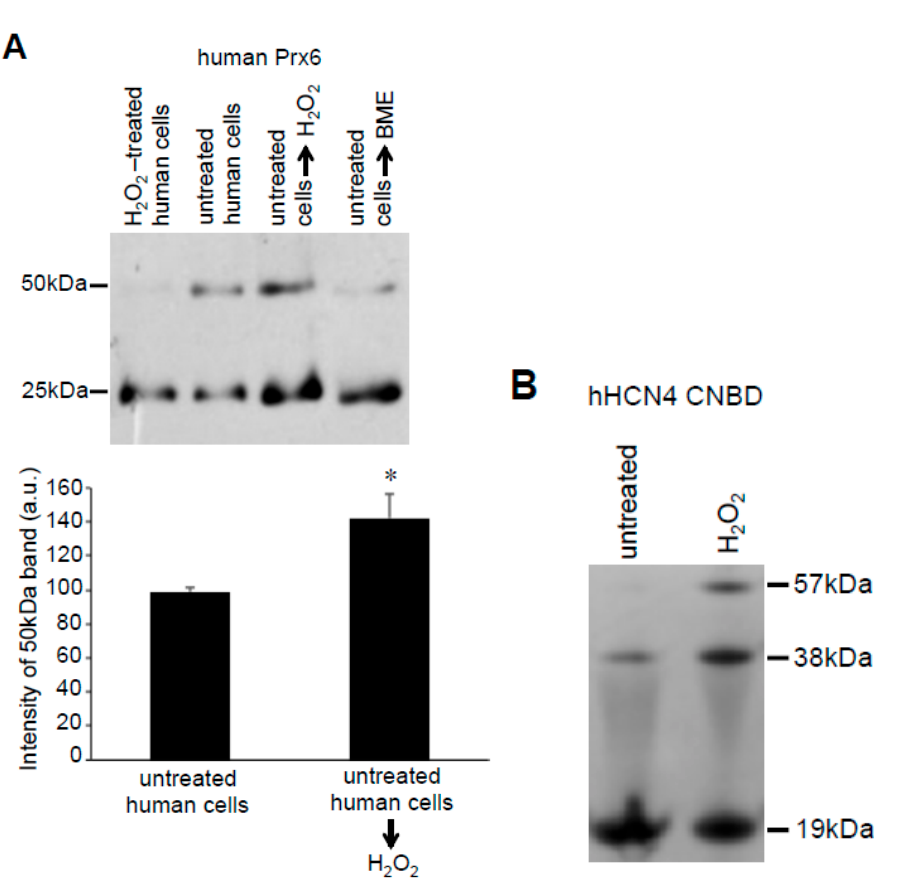
Figure 8. E ff ects of H 2 O 2 on the isolated proteins. ( A ) Cell lysates were prepared from untreated human pulmonary artery smooth muscle cells (Lane 2) or cells treated with H 2 O 2 for 15 min (Lane 1). Lysate proteins from untreated cells were denatured with SDS and incubated with H 2 O 2 (Lane 3) or BME (Lane 4) in a test tube for 15 min. Protein-SHifter Plus was then added and the samples subjected to SDS-PAGE and immunoblotted with the Prx6 antibody. The bar graph represents means ± SEM of the intensity of the 50-kDa band ( n = 3). The symbol * represents the value significantly di ff erent from the untreated control value at p < 0.05. ( B ) The purified recombinant CNBD domain of the hHCN4 channel was treated with H 2 O 2 (1 mM) for 15 min and subjected to SDS-PAGE followed by Coomassie Blue staining. No Protein-SHifters were used in these experiments.